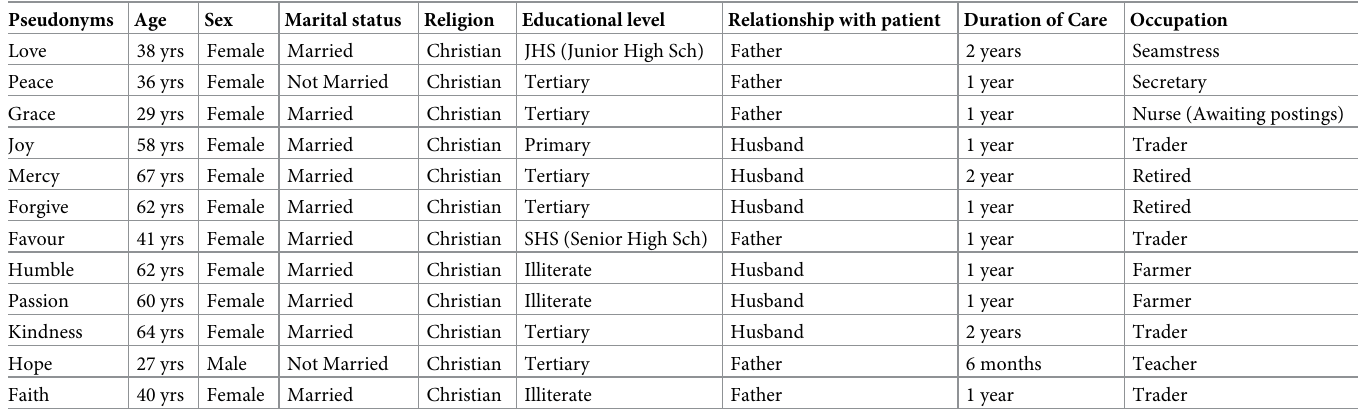
Table 1. Demographic characteristics of the participants of the